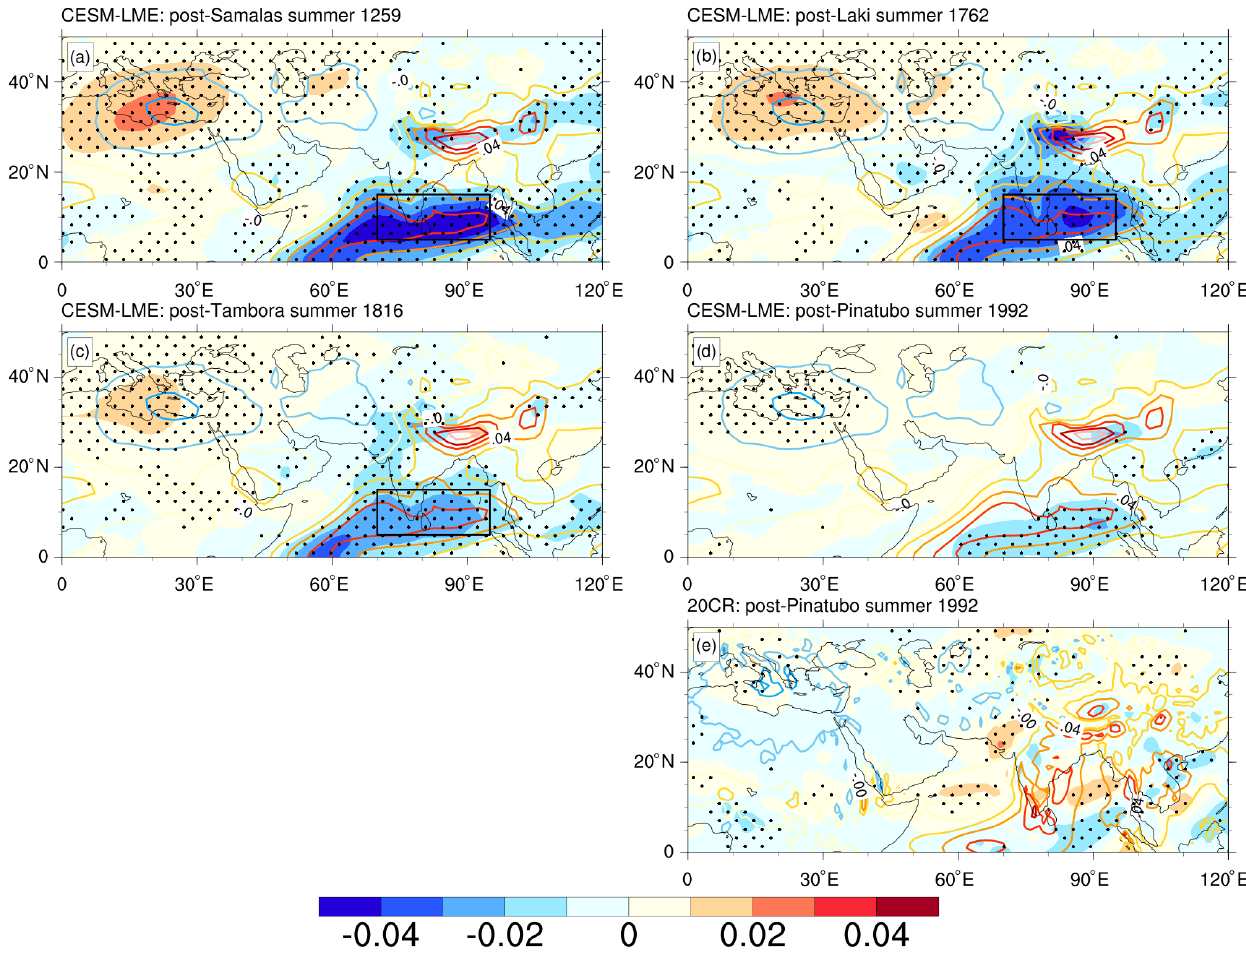
Figure 6. Anomalies of omega velocity ( − Pas − 1 ; shaded) at 200hPa in the post-eruption summers (JA) following Samalas, Laki, Tambora and Pinatubo. Climatology of omega velocity ( − Pas − 1 ) show regions of upwelling (red positive contours) and downwelling (blue negative contours). Panels (a) – (c) from CESM-LME and panel (e) from 20CR. Positive (negative) anomalies indicate reduced descending (ascending) motions. Anomalies relative to the average 5 years before the eruption year (see Table 1). Regions of p < 0 . 05 based on a two-tailed t test are stippled. See Fig. S4 for all eruptions listed in Table 1. Black boxes in panels (a) – (c) denote areas used for averaging omega velocity anomalies shown in Fig. 7. The negative sign in the unit of omega velocity denotes an upward